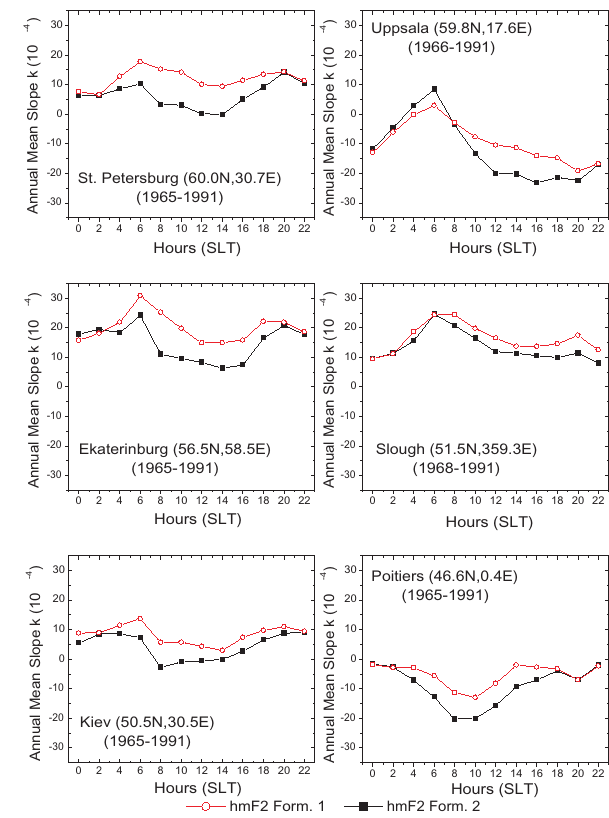
Fig. 1. Seasonal variation of the hm F2 trends at 6 European ionosonde stations and 4 moments of SLT. Regression of hm F2 with R 12 (Model 1) is used.